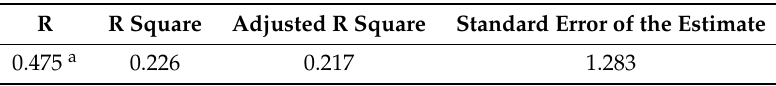
Table 15. Model summary.